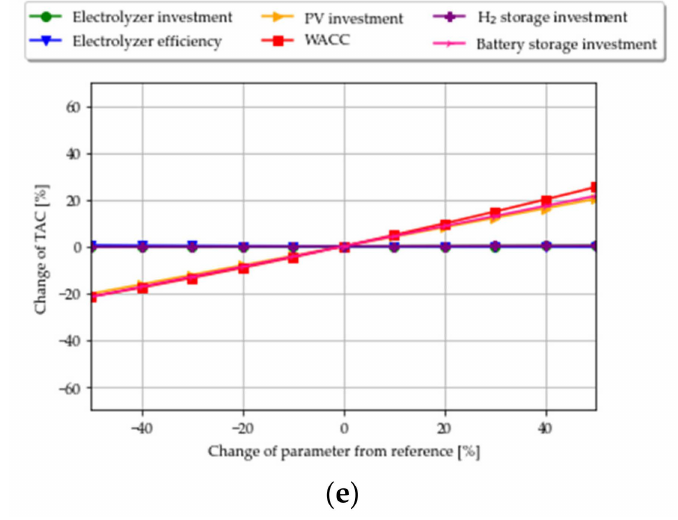
Figure A3. Sensitivity analysis for the respective optimal energy systems (see Section 3.1.1). The values are set in relation to the reference parameters assumed in 2022. ( a ) Stand-alone hydrogen production and utilization via combustion, ( b ) stand-alone electricity supply, ( c ) integrated hydro- gen production and utilization via combustion and electricity supply, ( d ) P2H2P-based e-cooking,